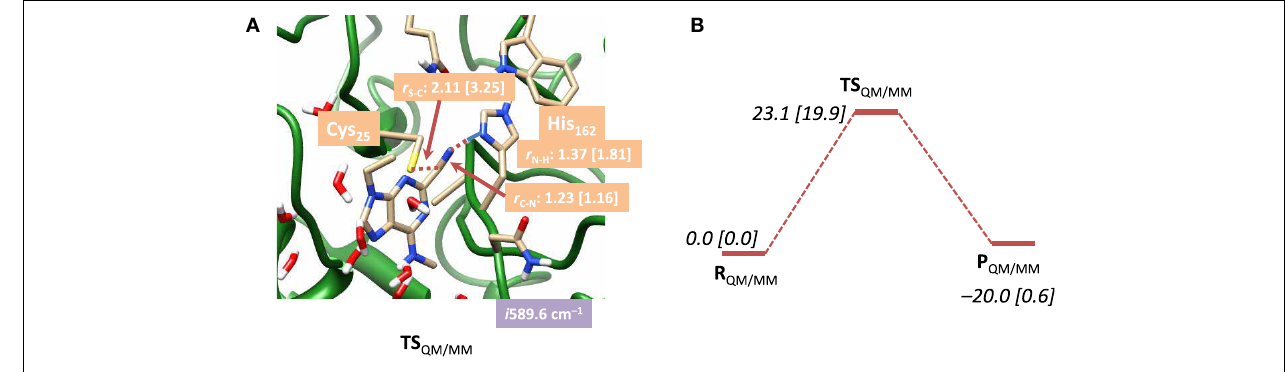
FIGURE 5 | (A) Optimized geometry with bond lengths in angstroms of TS QM / MM for nitrile-based inhibitors in cathepsin K as calculated with QM(B3LYP/6-311G)/MM. (B) Potential energy landscape from reactants to